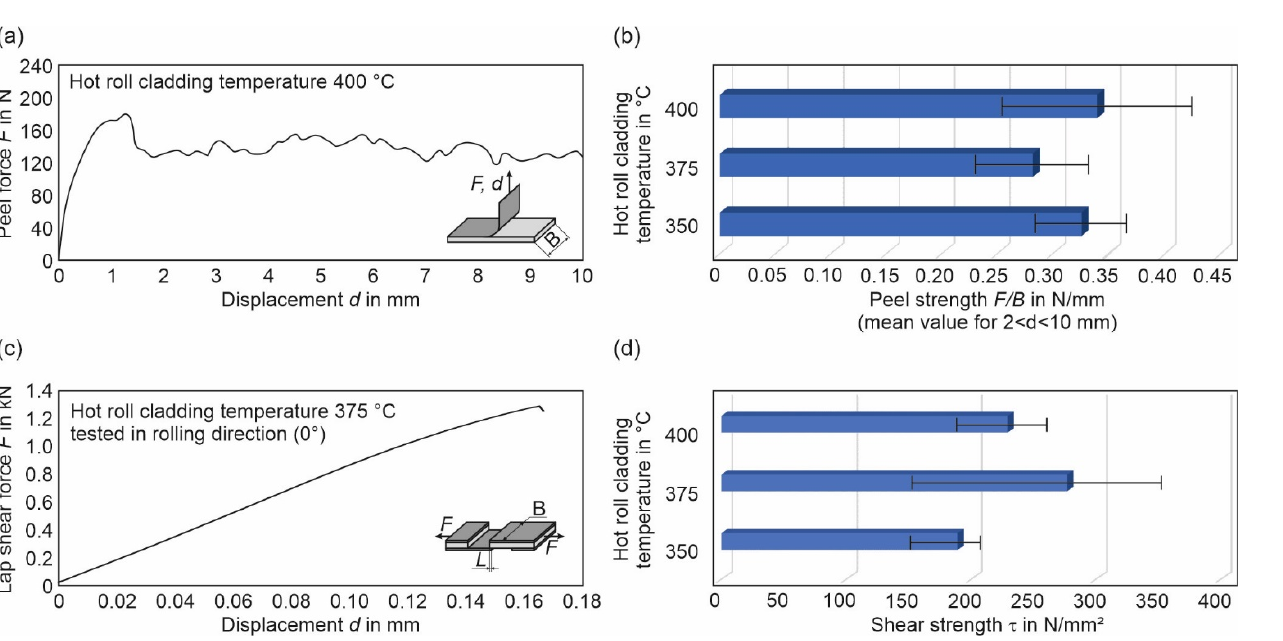
Figure 4. Cladding Result: overview, microscopic photograph and measurements.